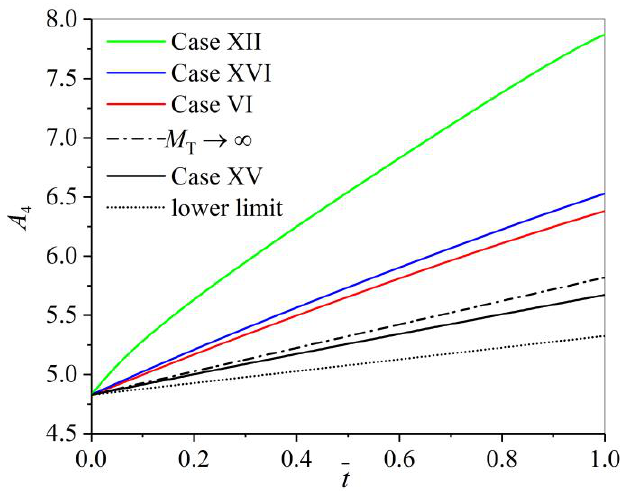
Figure 14. Increase of area A 4 of grain IV with respect to normalized time for different cases. Recently, Graux et al. [31] published optical micrographs of steel soaked at 1000 °C, 1100 °C and 1200 °C. While the austenite grains at 1000 °C and 1200 °C seem to be unimodally distributed, the grains at 1100 °C exhibit a deviation from the unimodal distribution. (Ti,Nb)C precipitates are made responsible for pinning austenite grain boundaries. Due to the thermodynamic calculations presented in [31], it can be concluded that the (Ti,Nb)C precipitates are present at 1000 °C and 1100°C and dissolve at 1200 °C and higher temperatures. The microstructures are analyzed by means of software Fiji [48]. As an example the microstructure indicating a bimodal area distribution for thermal etching at 1100°C is shown in Figure 15a. The grains are approximated by ellipses, where d is defined as the major axis and c is the minor axis (Figure 15b). The c / d ratio is a measure for the deviation of the grains from the circle shape ( c / d = 1).